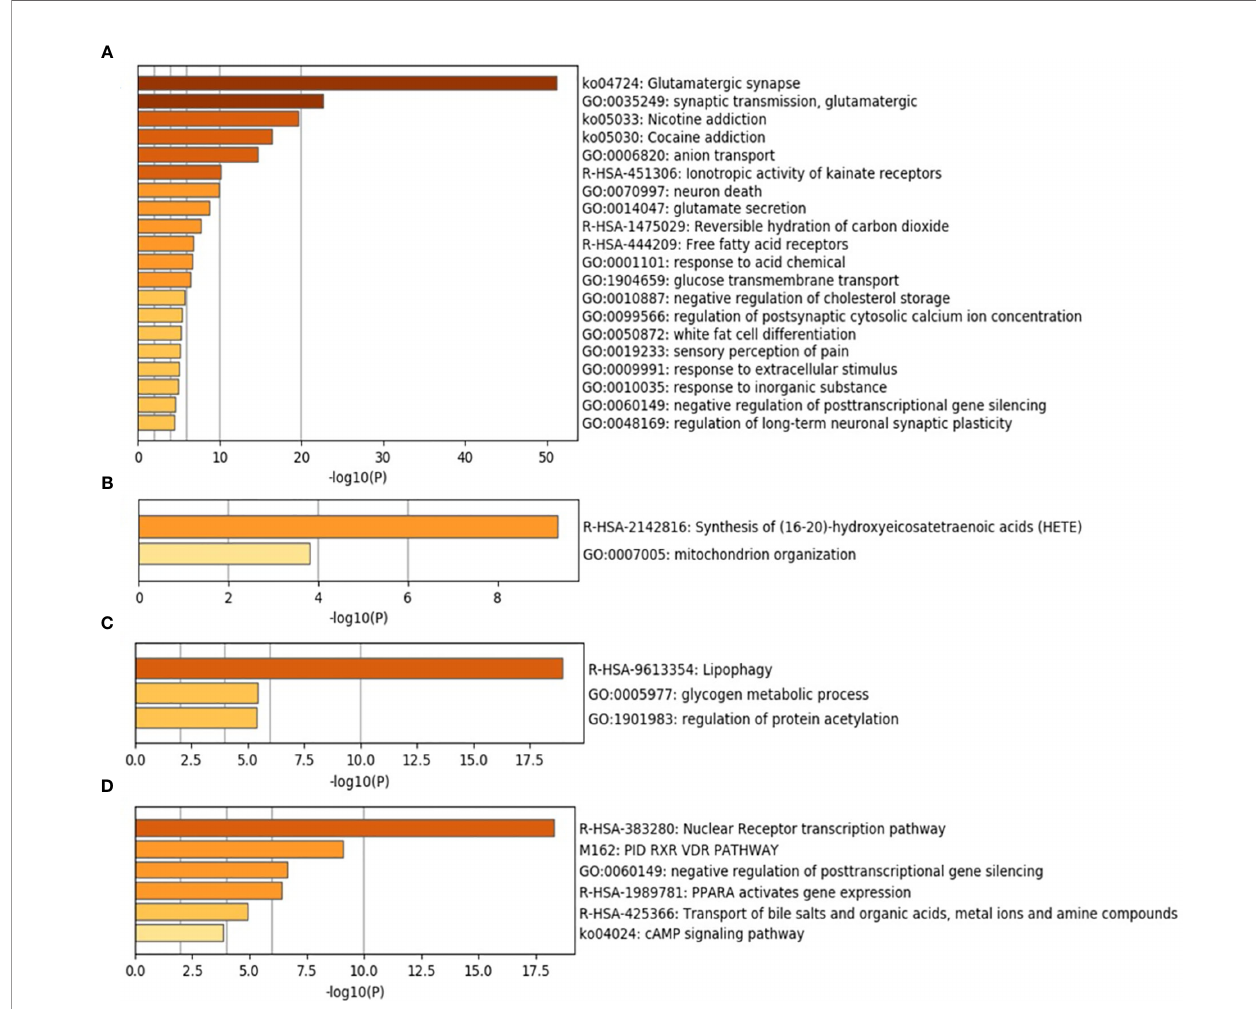
FIGURE 5 | Top 20 pathways and functional enrichment analysis using Metascape. The y -axis shows signi fi cantly enriched gene ontology terms of the target genes. The darker the color, the higher the gene counts included in that pathway. The x -axis shows the enrichment scores of the gene ontology terms. P -value is calculated according to the count of the provided genes found in the given pathway. Log10( P ) is the P -value in log base 10. P -value ≤ 0.05 was considered as signi fi cant. (A) Healthy control. (B) Periapical abscess. (C) Radicular cyst. (D) Periapical